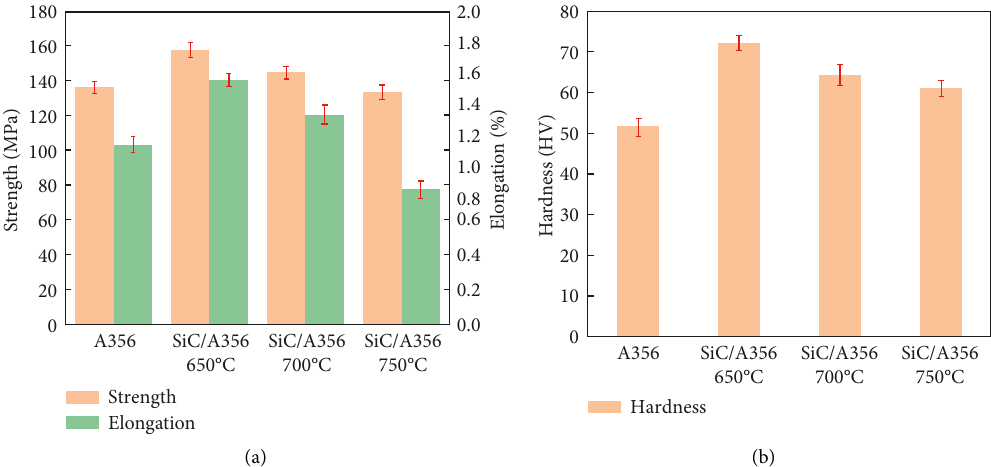
Figure 4: Mechanical properties of the SiC p /A356 composites at different conditions: (a) tensile strength; (b)